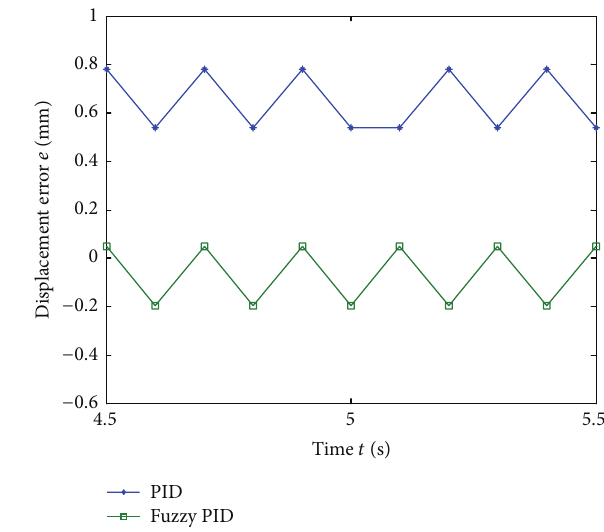
Figure 14: Error of comparing